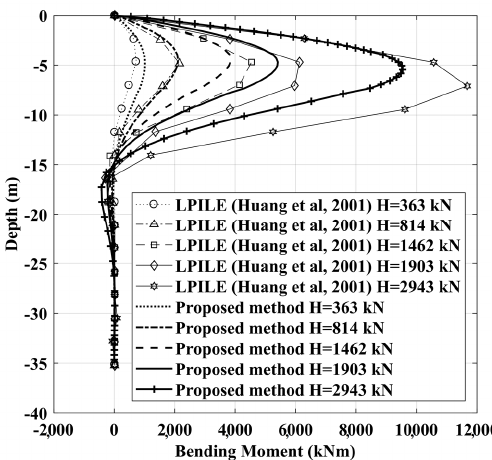
Figure 13. Computed bending moments of B7 single pile at various load levels (results obtained considering suction). considering